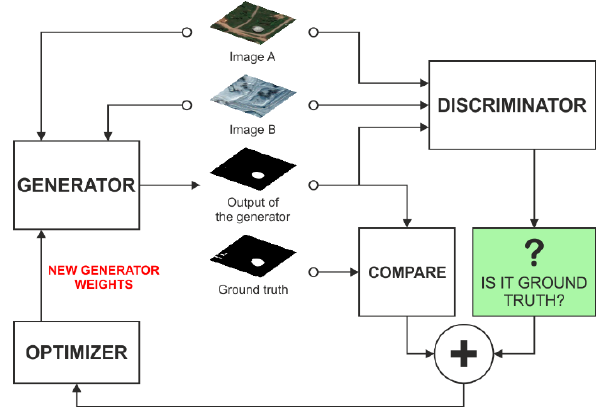
Figure 3. The training pipeline of the generator